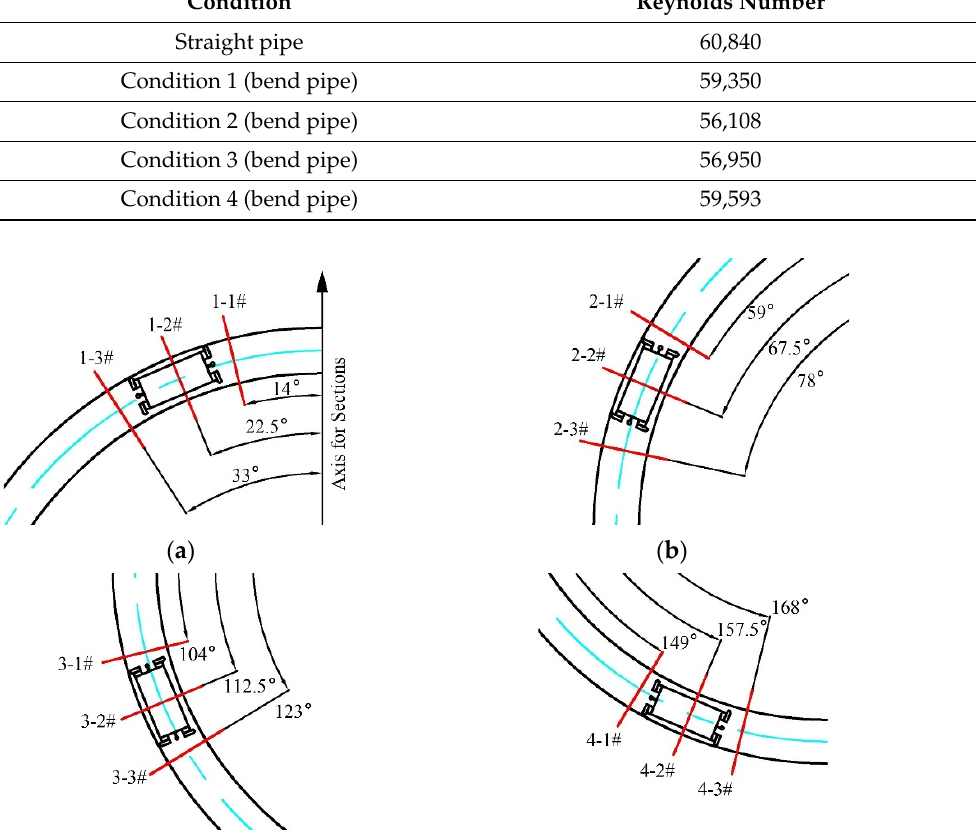
Figure 4. Analysis section layout: ( a ) location θ = 22.5° (first condition); ( b ) location θ = 67.5° (sec- ond condition); ( c ) location θ = 112.5° (third condition); ( d ) location θ = 157.5° (fourth condition). The symbols # are the marks of sections; the red lines are the locations of sections; the blue lines are the axis of the pipeline. Table 2. Threshold of motion Reynolds numbers for different conditions.